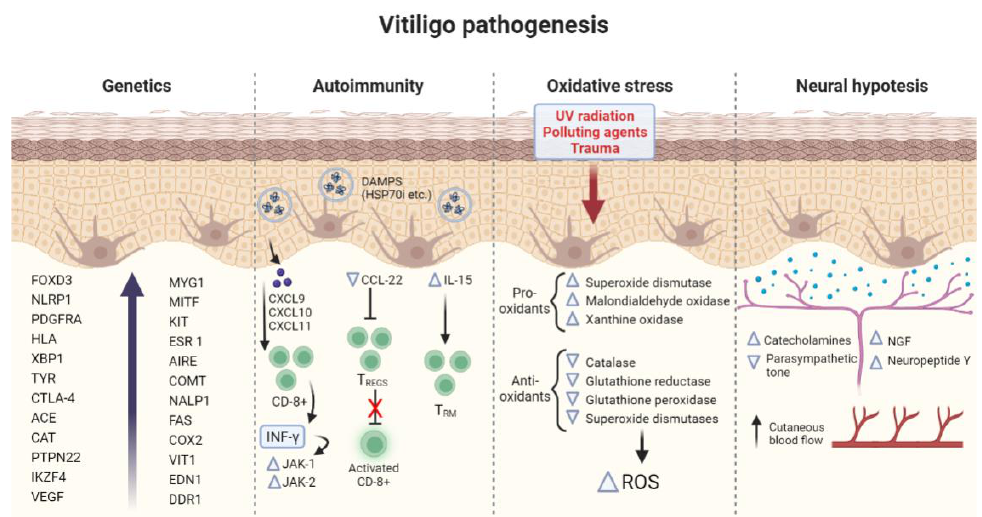
Figure 1. Summary of the main pathogenetic mechanisms involved in vitiligo. FOXD3 (Forkhead Box D3), NLRP1 (NLR family pyrin domain containing 1), PDGFRA (Platelet Derived Growth Factor Receptor Alpha), HLA (human leukocyte antigen), XBP1 (X-box binding protein 1) TYR (Tyrosinase), CTLA-4 (Cytotoxic T-Lymphocyte Antigen 4), ACE (Antigen converting enzyme), CAT (Catalase), PTPN22 (Protein Tyrosine Phosphatase Non-Receptor Type 22), IKZF4 (IKAROS Family Zinc Finger 4, VEGF (Vascular endothelial growth factor), MYG1 (MYG1 Exonuclease), MITF (Melanocyte Inducing Transcription Factor), KIT (KIT Proto-Oncogene, Receptor Tyrosine Kinase), ESR 1 (Estrogen Receptor 1), AIRE (Autoimmune Regulator), COMT (Catechol-O-methyltransferase), NALP1 (Nucleotide-binding oligomerization domain, Leucine-rich Repeat and Pyrin domain containing), FAS (Fas Cell Surface Death Receptor), EDN1 (Endothelin 1), COX2 (Cyclooxygenase 2), VIT1 (Vacuolar iron transporter 1), CXCL9-10-11 (C-X-C Motif Chemokine Ligand 9-10-11), DAMPs (Damage-associated molecular patterns), HSP70 (Heat Shock Protein 70 kilodaltons), CCL22 (C-C Motif Chemokine Ligand 22), IL-15 (Interleukin-15), CD8 (cluster of differentiation 8, IFN- γ (Interferon gamma), JAK1 – 2 (Janus Kinases 1 and 2), TREGS (regulatory T cells ), TRM (Resident memory T cells), ROS (Reactive oxygen species), and NGF (Neural growth factor).